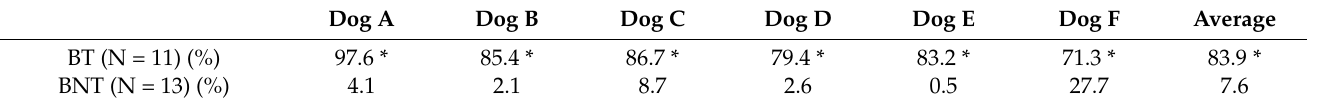
Table 3. The individual and total average lung cancer diagnostic rate of six dogs trained using exhaled breathing target samples are significantly different between the lung cancer group and healthy subjects group.